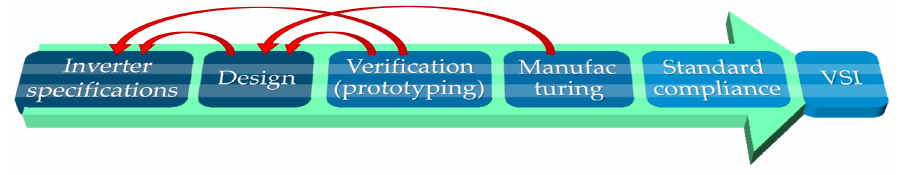
Figure 2. Power inverter traditional design